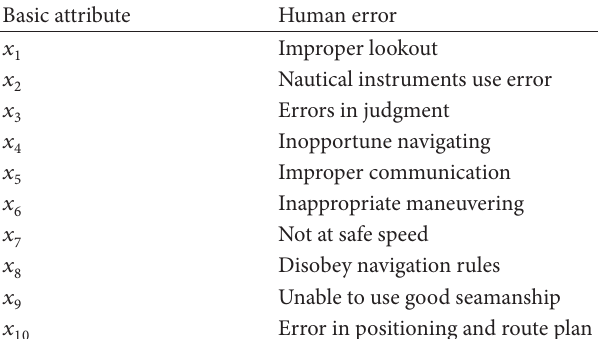
Table 4: Corresponding relationship between human errors and basic attributes.